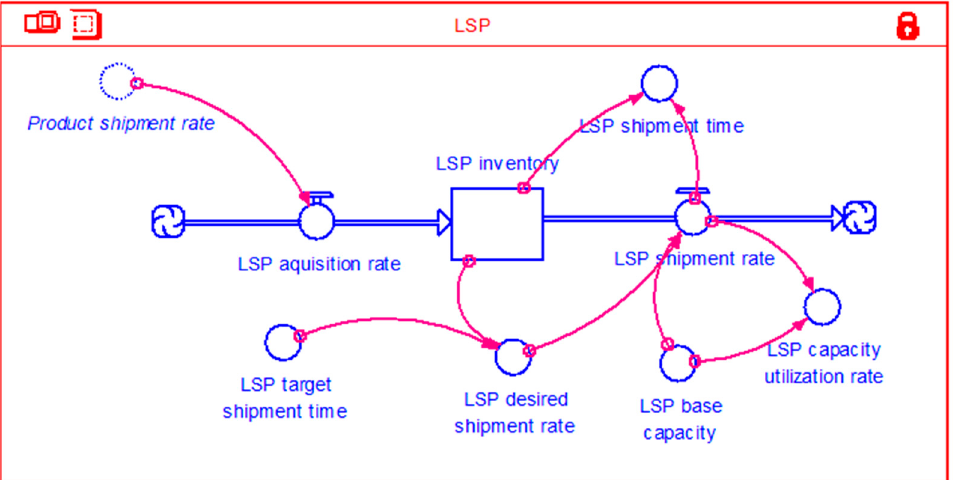
Figure 3. LSP’s operation simulation model for Scenario